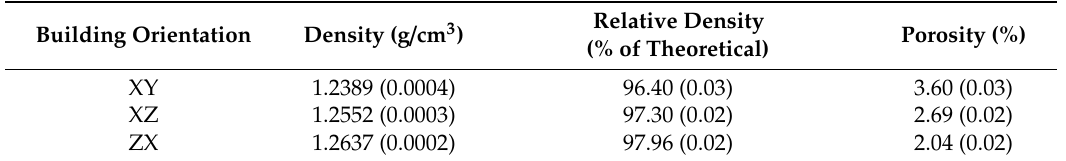
Table 1. Average values of densities and porosity (standard deviations in parenthesis) of printed parts for the di ff erent building